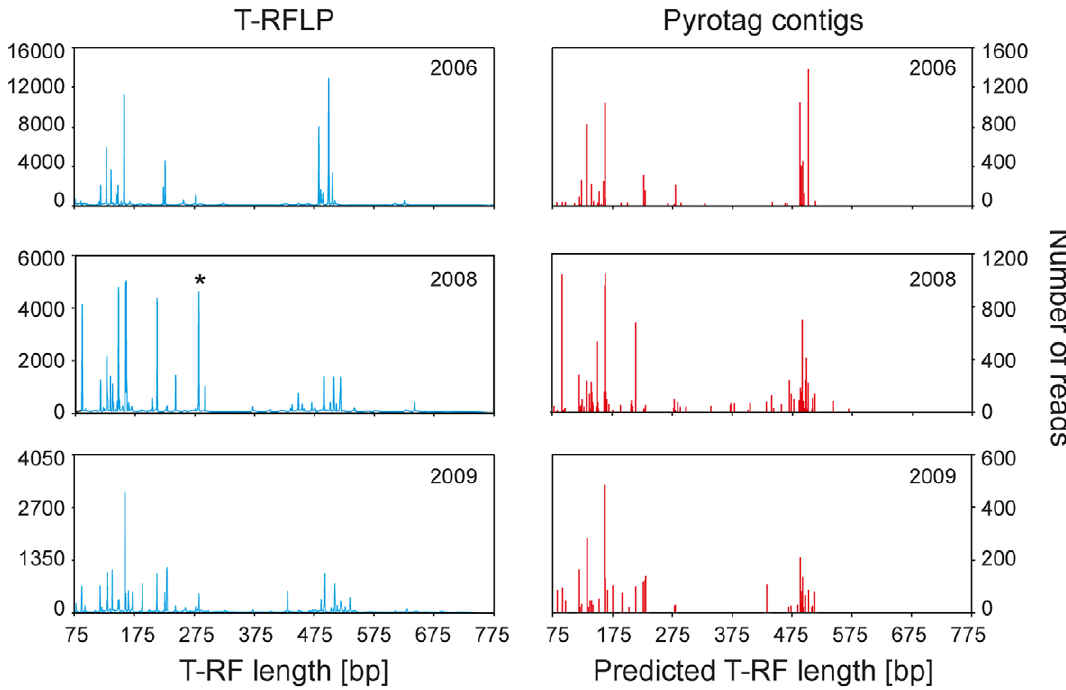
Figure 3. Comparison of bacterial community structure as recovered in T-RFLP fingerprinting and pyrotag libraries. Results are shown for selected aquifer sediment DNA extracts (replicate b from each year). For pyrotag ‘fingerprints’, the abundance of dominating assembled contigs is illustrated via T-RFs predicted in silico along with the total number of reads contributing to that contig. (*) illustrates the 282 bp pseudo T- RF of specific Spirochaete populations detected as in vivo T-RF only.